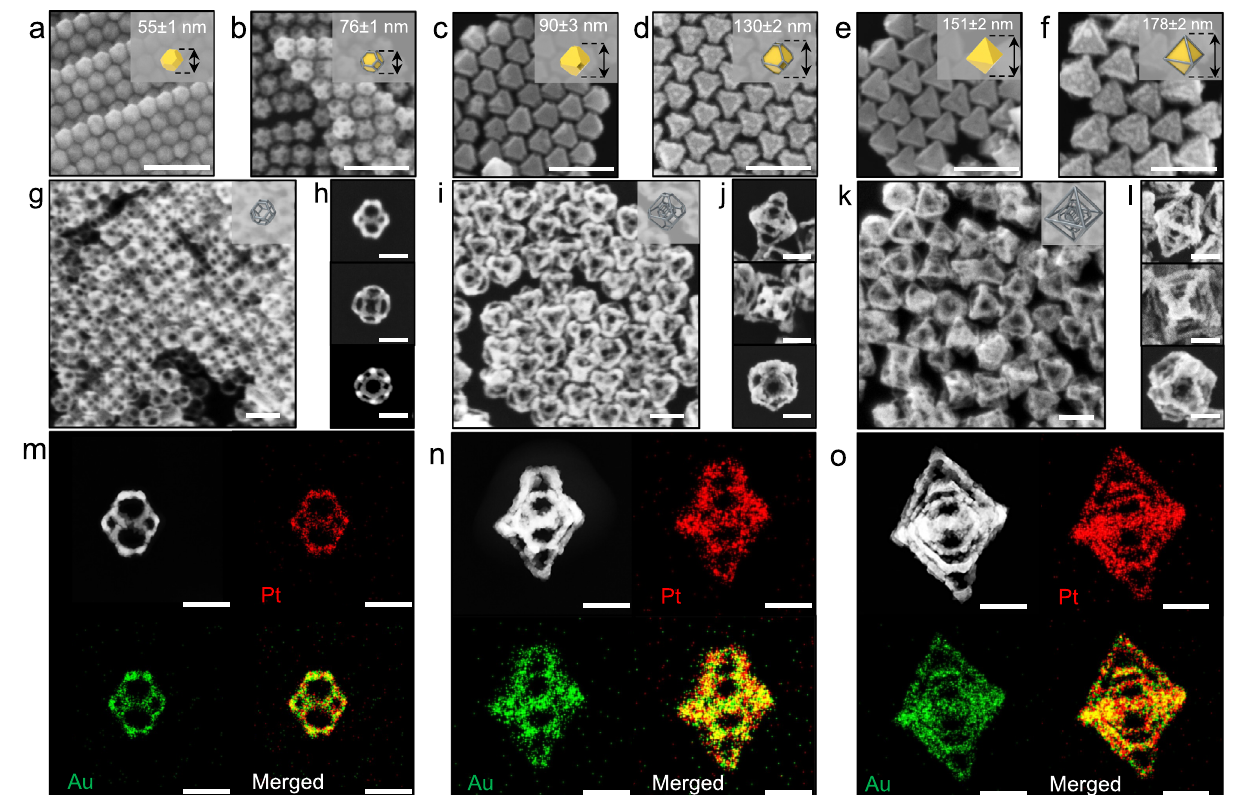
Fig.3|Morphologyevolutionfrom1 st to3 rd nanoframes. SEMimagesof a 1 st -Au- TO-NPs, b 1 st -Au@Pt-TO-NPs, c 2 nd -Au-TO-NPs, d 2 nd -Au@Pt-TO-NPs, e 3 rd -Au-O-NPs, and f 3 rd -Au@Pt-O-NPs, scale bar = 200nm. g – l Low magni fi cation and